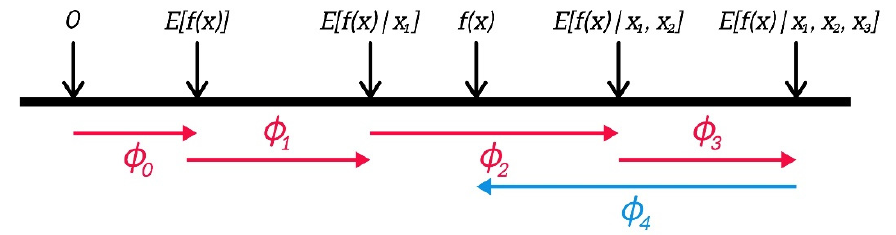
Figure 4. SHAP explanation of machine learning prediction with four variables (adopted from [26]).